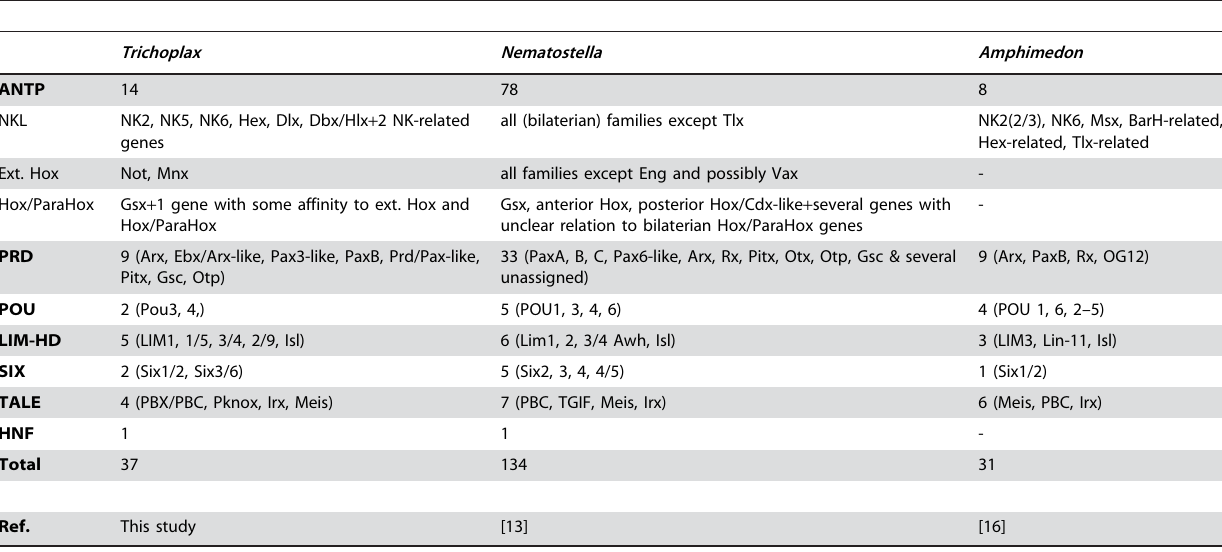
Table 1. The homeobox gene complement of Trichoplax adhaerens shows a slightly higher diversity of the homeobox classes ANTP, PRD and